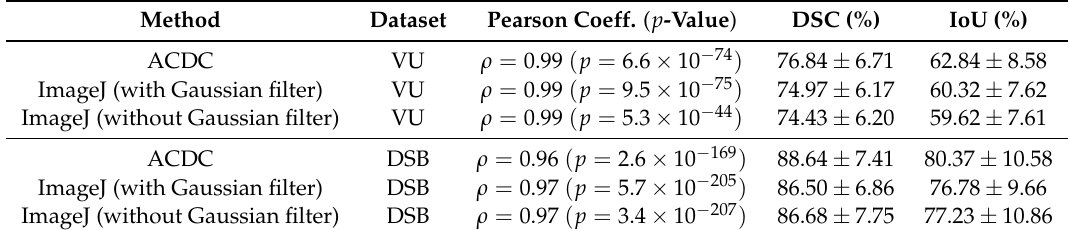
Table 2. Comparison of ACDC and the tested ImageJ pipelines in terms of cell nuclei counting and segmentation. The results are expressed as mean value ± standard